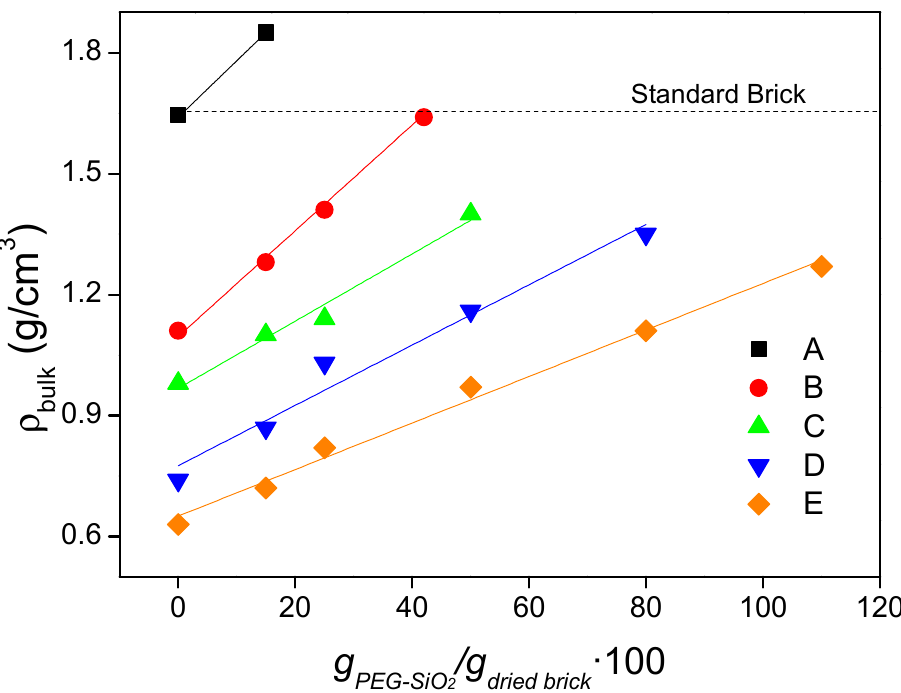
Figure 4. Bulk density of the composites as a function of the PEG-SiO 2 content.